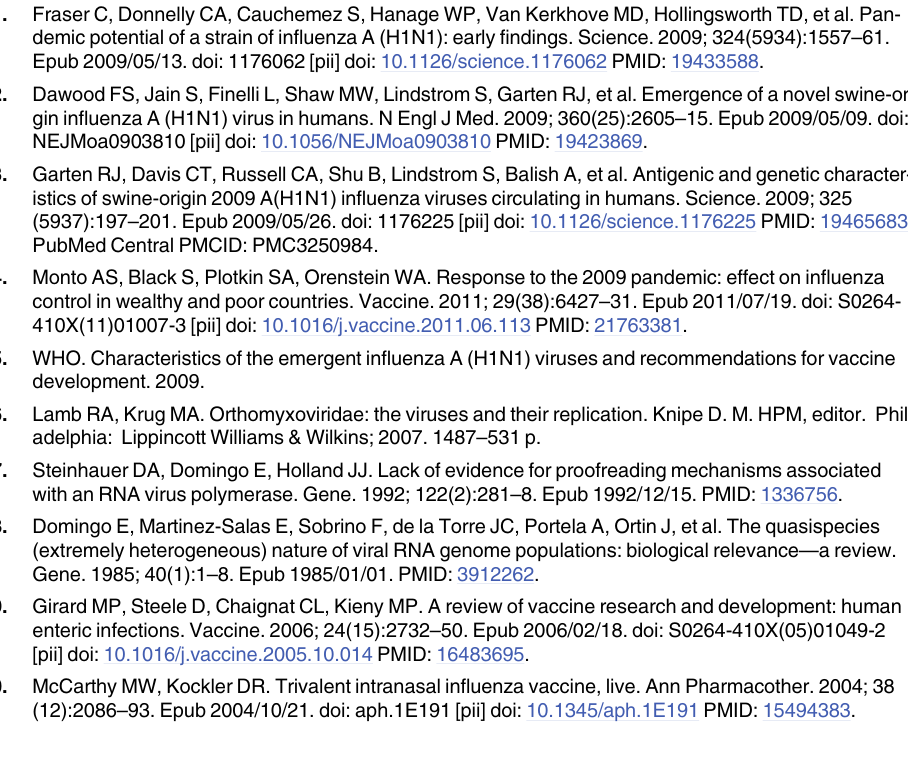
S6 Table. Percentage of mutations ( (cid:3) 5%) emerged in X-179A viruses generated by using RNA library preparation followed by HiSeq sequencing. S7 Table. Percentage of mutations ( (cid:3) 5%) emerged in X-179A viruses generated by using DNA library preparation followed by HiSeq sequencing. S8 Table. Percentage of mutations ( (cid:3) 5%) emerged in X-181 viruses generated by using RNA library preparation followed by MiSeq sequencing. S9 Table. Percentage of mutations ( (cid:3) 5%) emerged in X-181 viruses generated by using RNA library preparation followed by HiSeq sequencing. S10 Table. Percentage of mutations ( (cid:3) 5%) emerged in X-181 viruses generated by using DNA library preparation followed by HiSeq